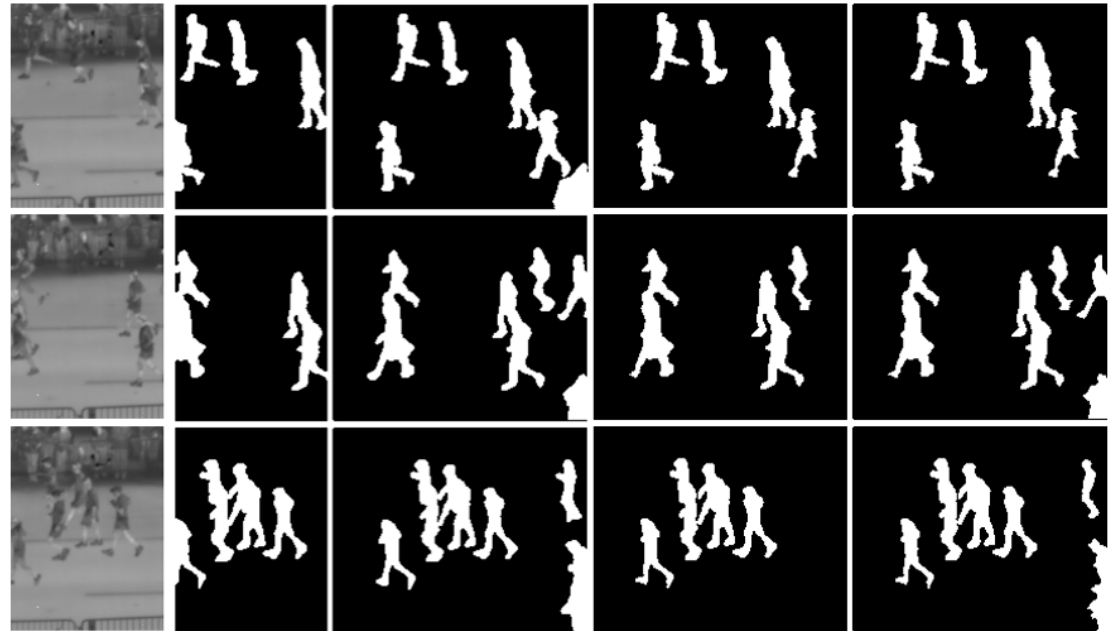
Figure 15. Comparisons of detection results using original images, GT images, and the predicted images obtained by the state-of-the-art methods and the proposed method: ( a ) original images; detection results using ( b ) original images and ( c ) GT images of Figures 11b, 12b and 13b; and the images predicted by ( d ) Shin et al. [19], ( e ) Nazeri et al. [21], and ( f ) the proposed method.